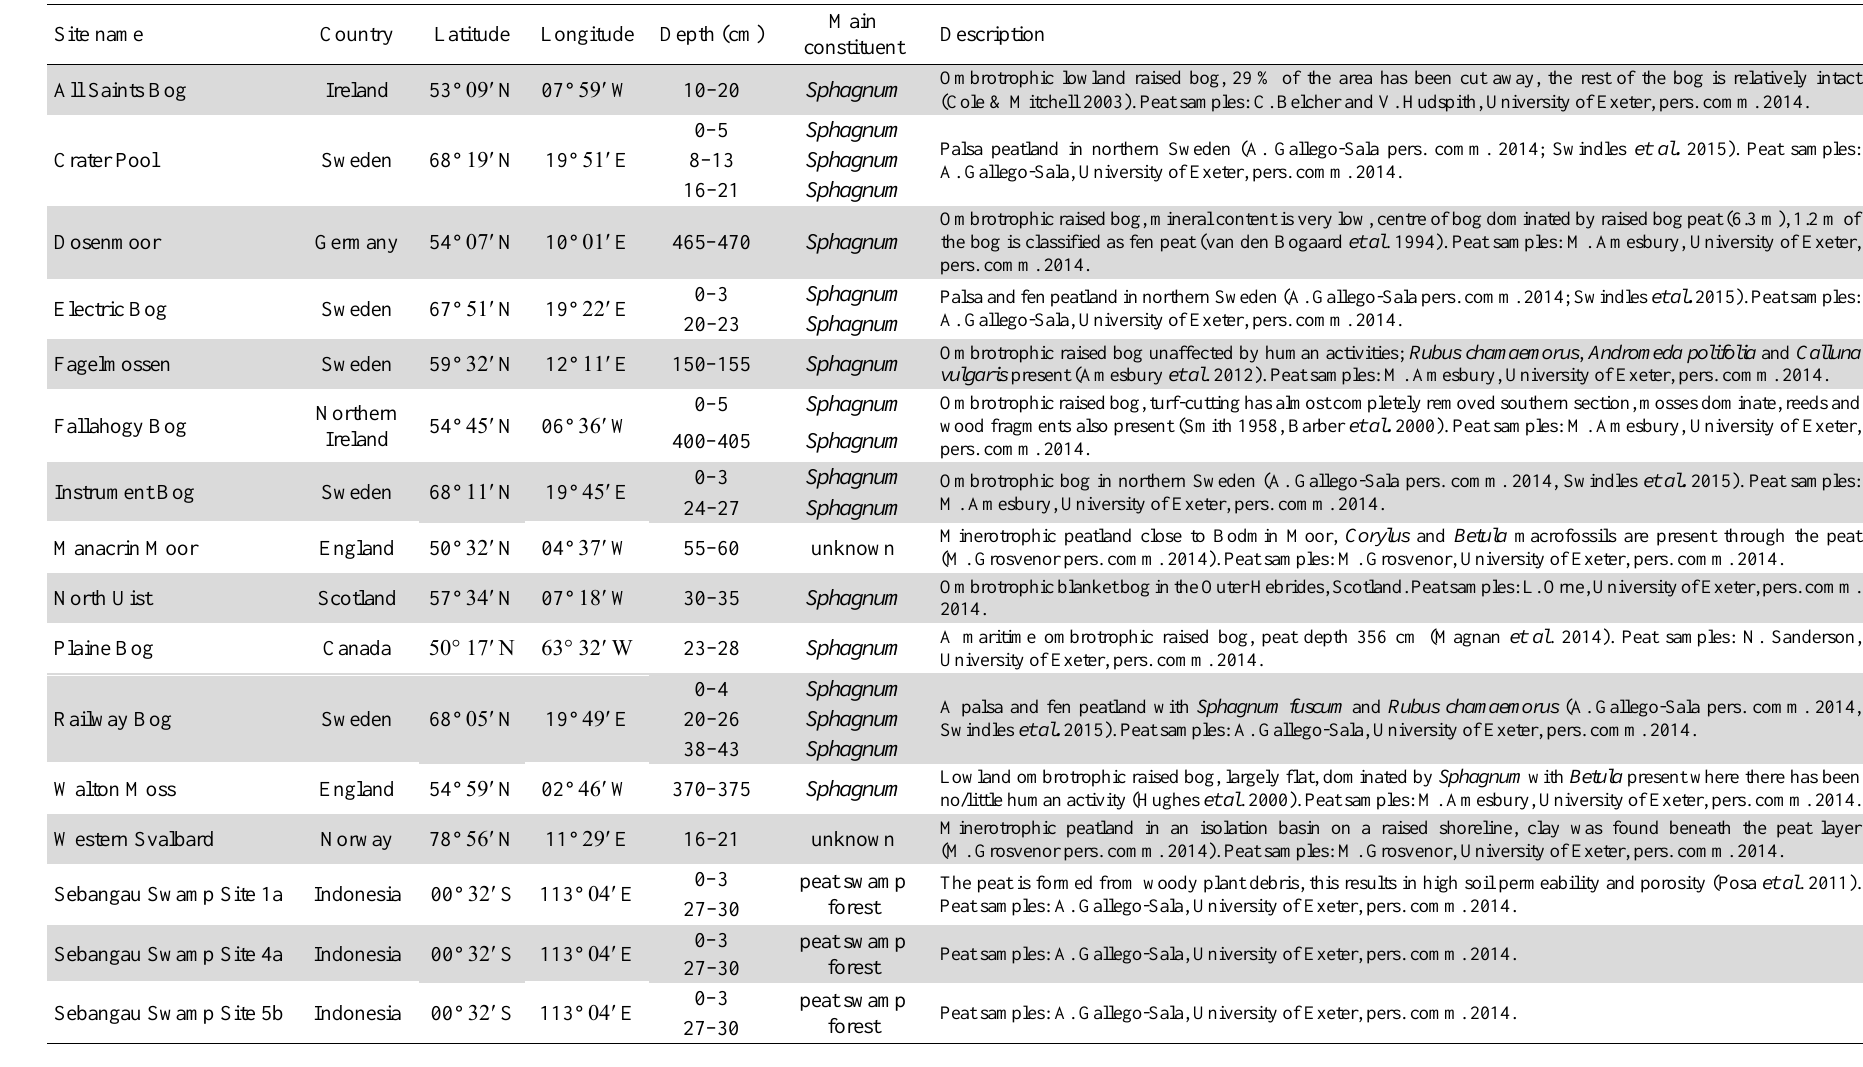
Table 1. Detailed list of the peat samples analysed. The coring locations and the depths in the cores and monoliths from which the samples were taken are provided, along with the main vegetation constituent of each